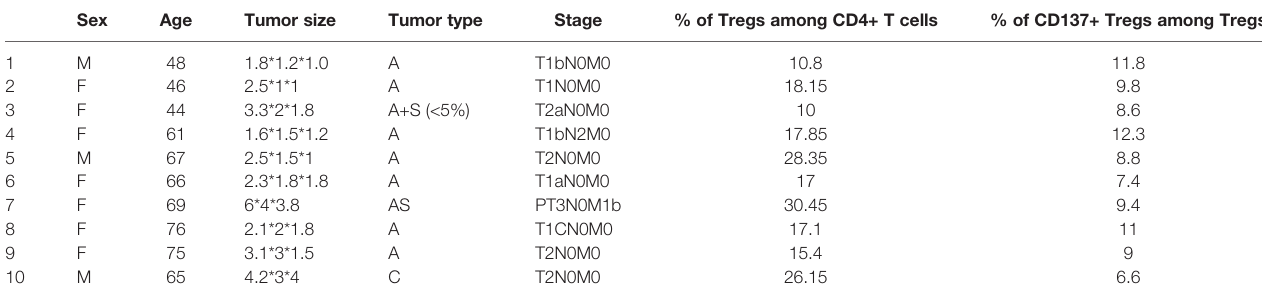
TABLE 2 | Tumor sample characteristics and CD137+ Treg in fi